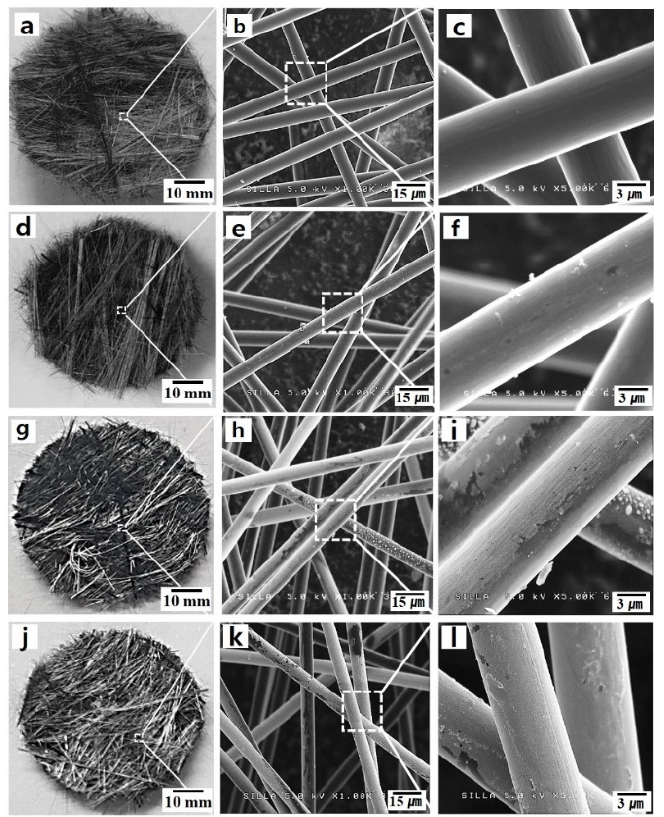
Figure 5. ( a ), ( d ), ( g ), and ( j ) are photographs; ( b ), ( e ), ( h ), and ( k ) are field-emission scanning electron microscopy (FESEM) images; and ( c ), ( f ), ( i ), and ( l ) are magnified FESEM images. From top of bottom, each column of images shows native carbon-based nonwoven fabrics (c-NFs) samples, plasma-treated c-NFs samples, Ag-coated c-NFs samples, and plasma-treated Ag-coated c-NFs samples, respectively.